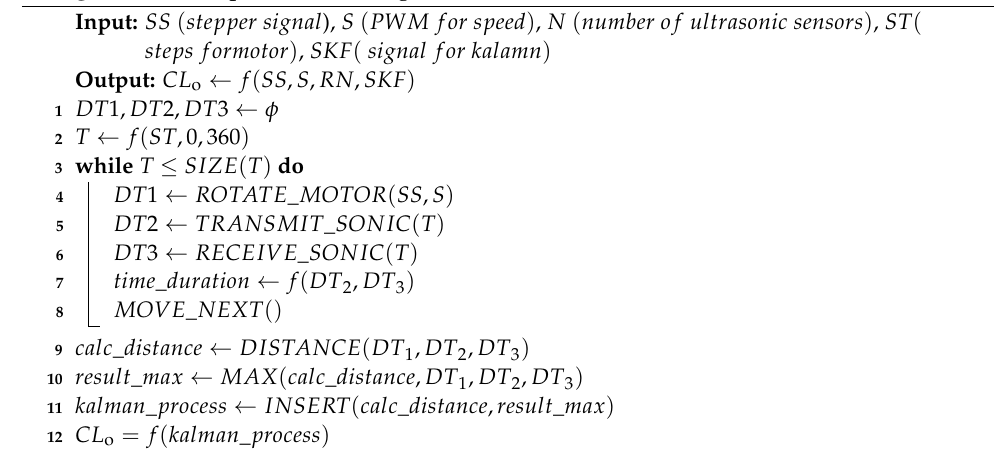
Algorithm 1 Proposed Tricon algorithm for the ultrasonic sensors.